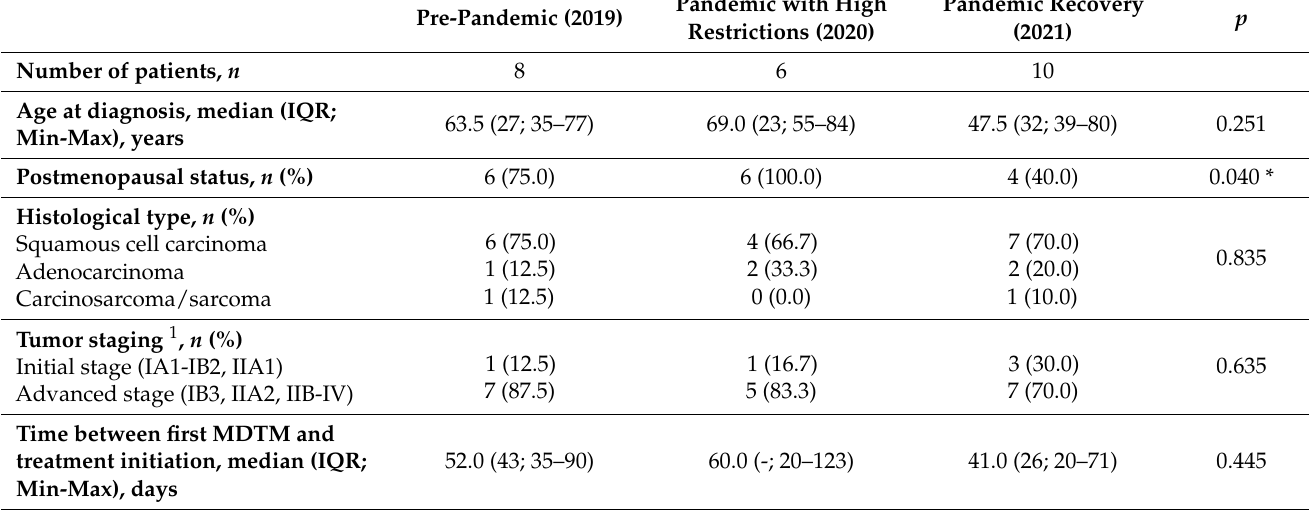
Table 3. Epidemiological, clinical and pathological patterns of patients diagnosed with cervical cancer ( n =